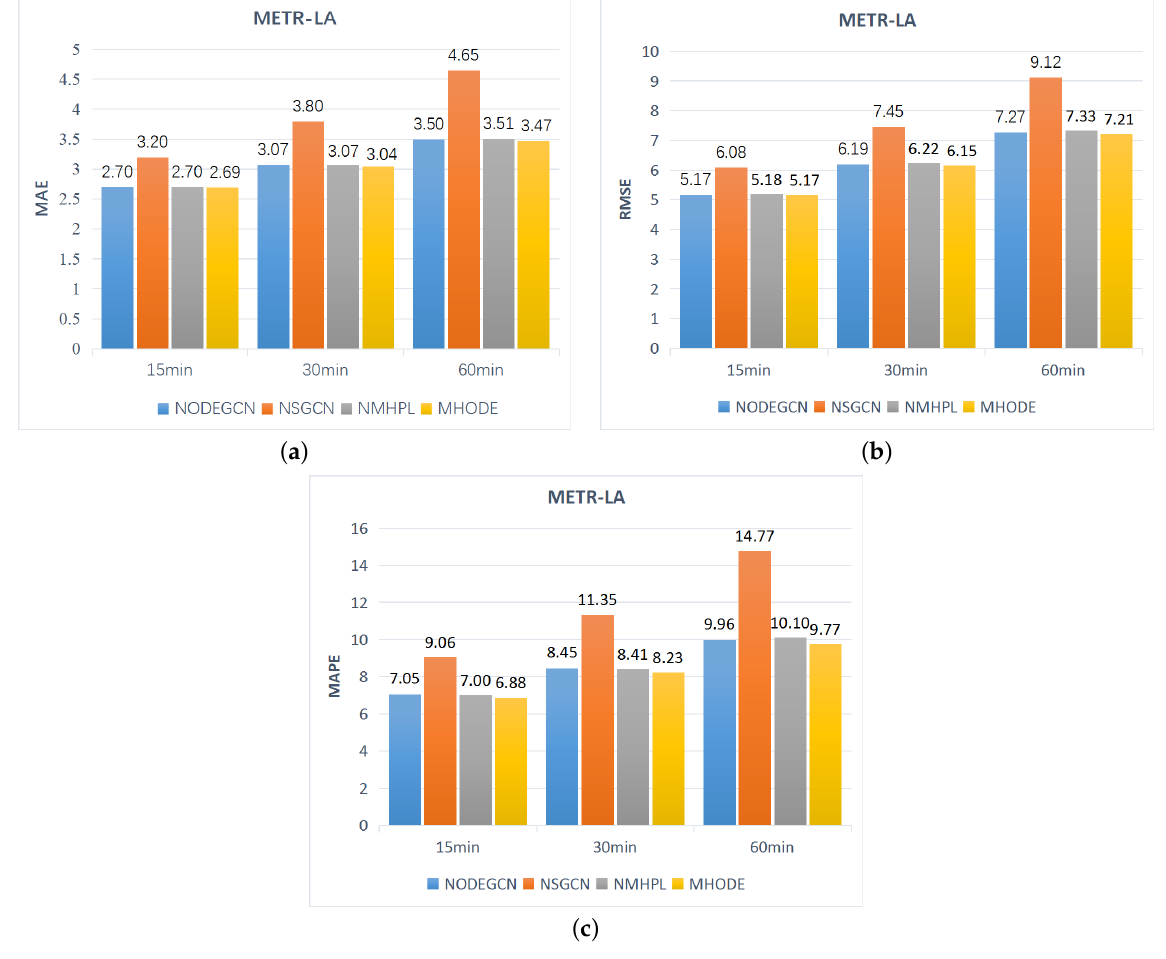
Figure 6. Experimental results for different variant models: ( a ) the MAE of the variant model on METR-LA; ( b ) the RMSE of the variant model on METR-LA; ( c ) the MAPE of the variant model on METR-LA.